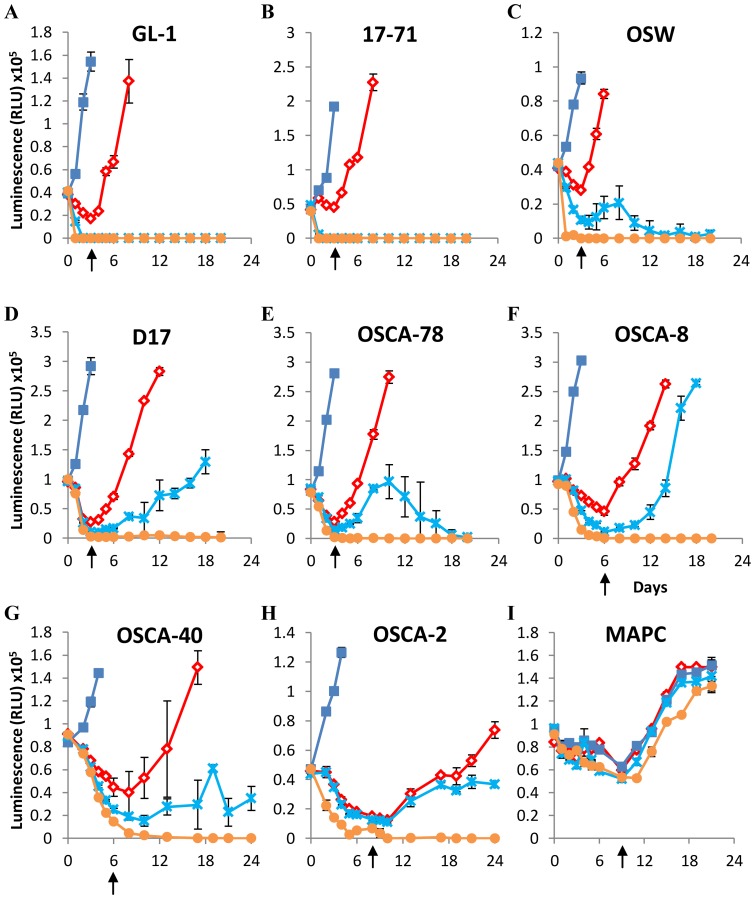
Arginase supplementation can prevent recovery of canine lymphoid cells and osteosarcomas subjected to arginine-deprivation.Canine lymphoid cells and osteosarcomas (A–H), and MAPC (I) were cultured in Arginine-free media for 3 days with or without arginase supplementation as indicated below. Arginase was removed and arginine reintroduced into cultures on day 3 (A–E), day 6 (F, G), day 8 (H), or day 9 (I) as indicated by the arrows. Cell viability was determined by ATP quantification. Blue squares = +1 mM Arginine, Red diamonds = Arginine-free, Blue crosses = +1 U/ml Arginase, Orange circles = +10 U/ml Arginase. Graphs show a representative experiment from three independent experiments with similar results. Error bars represent SD.